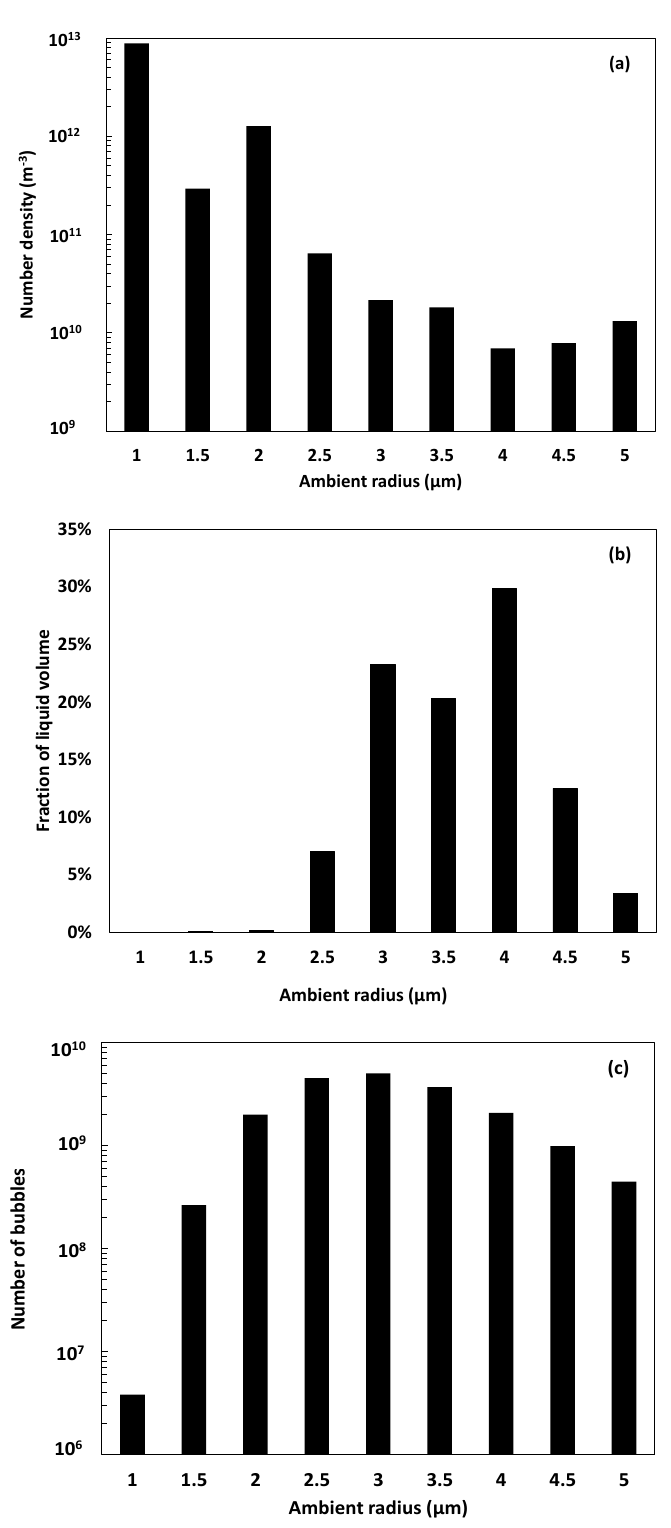
Figure 7. Number density within homogeneous population ( a ), distribution of liquid volume ( b ), and distribution of the number of bubbles ( c ), in function of the ambient radii. The rates of the sonochemical production of HO • , HO (cid:2870)• , and H • have been first esti- mated at the single bubble scale, considering the 9 different equilibrium radii ranging from 1 to 5 µm, and using Equation (11). The production rates within a homogeneous population of a given ambient radius are calculated using Equation (19), while Equation